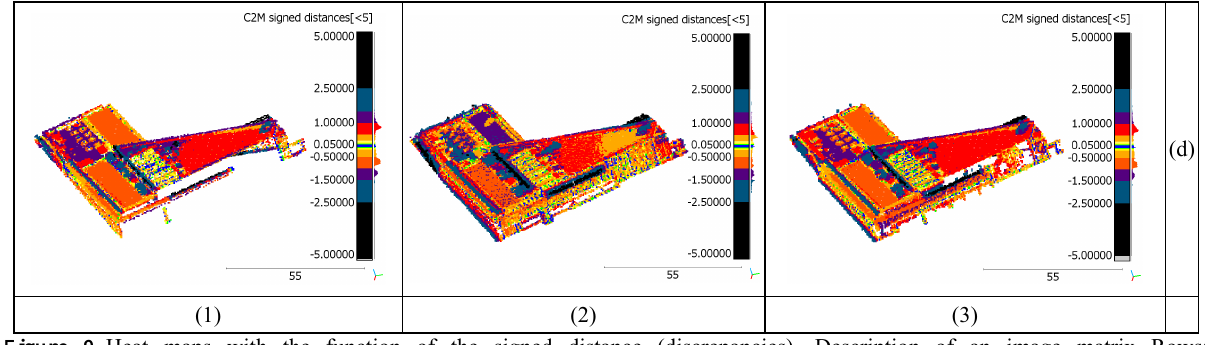
Figure 9 . Heat maps with the function of the signed distance (discrepancies). Description of an image matrix Rows: (a) and (b) – Geoportal model, (c) and (d) – SketchUp model; Columns: (1) – ISOK LiDAR point cloud, (2) – RIEGL LMS-Q680i LiDAR point cloud; (3) – image-based Phase One iXU-RS 1000 point